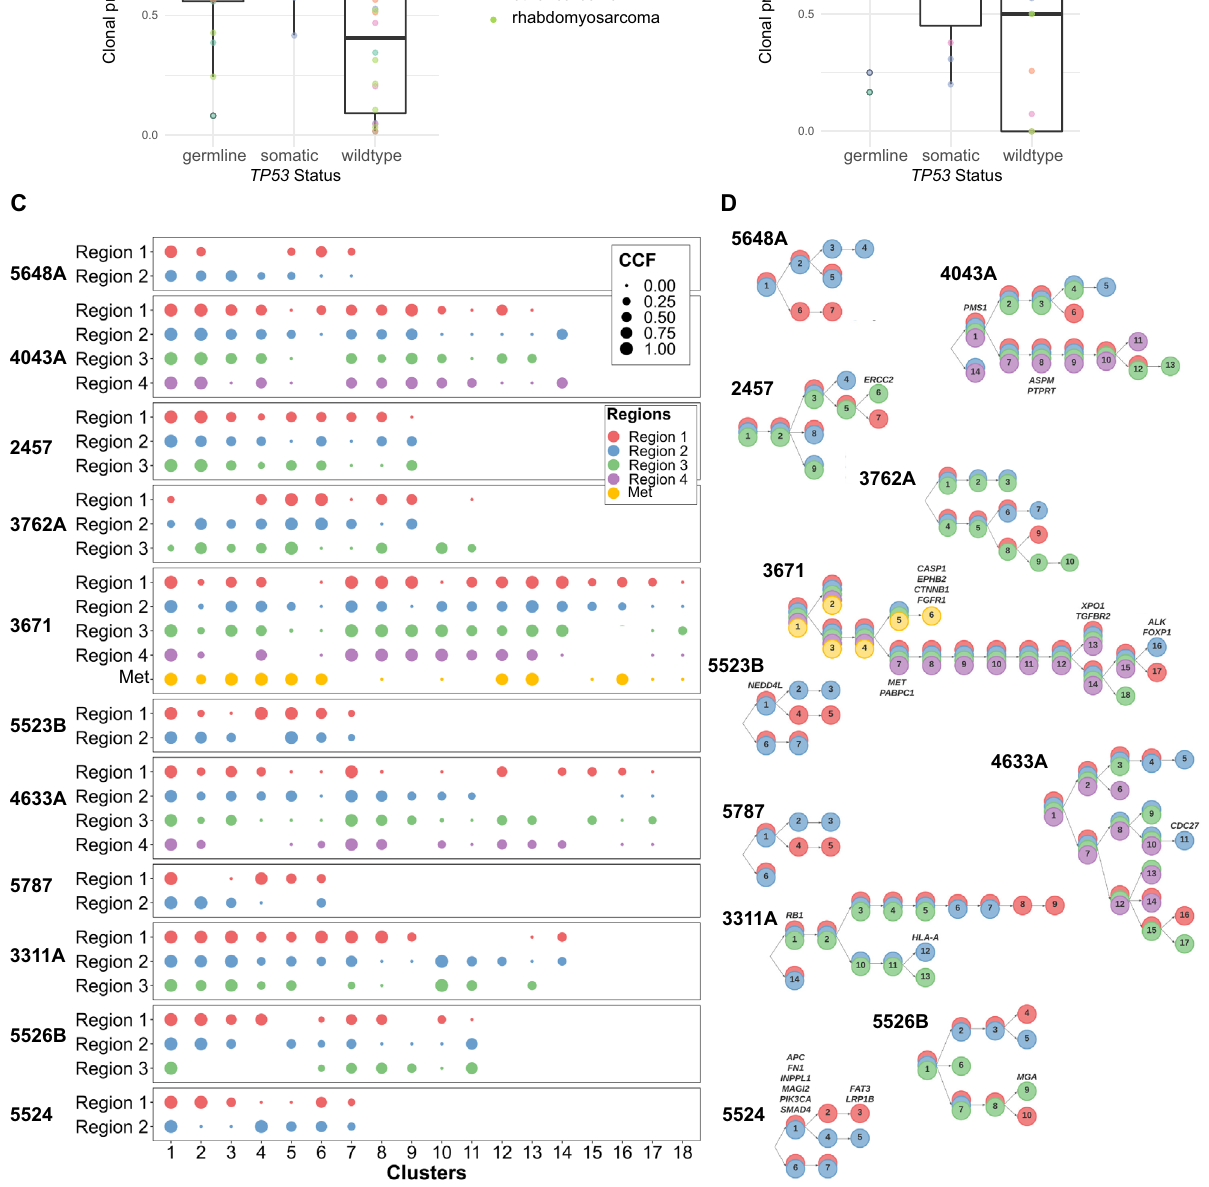
proportion of CNVs which are clonal. C , D Phylogenetic reconstructions of LFS tumors using multiregion WGS ( C ) Circle plots, with subclonal cluster number on X -axis and tumor region on Y -axis. Circles are colored by tumor region. Circle diametercorrespondstocancercellfraction(CCF)foreachclusterforeachtumor region. D Phylogenetictreereconstructionsofeachmultiregionsequencedtumor with colors corresponding to tumor region, numbers corresponding to cluster numberandannotatedwithlocationofdrivermutations.Sourcedataareprovided as a Source Data fi